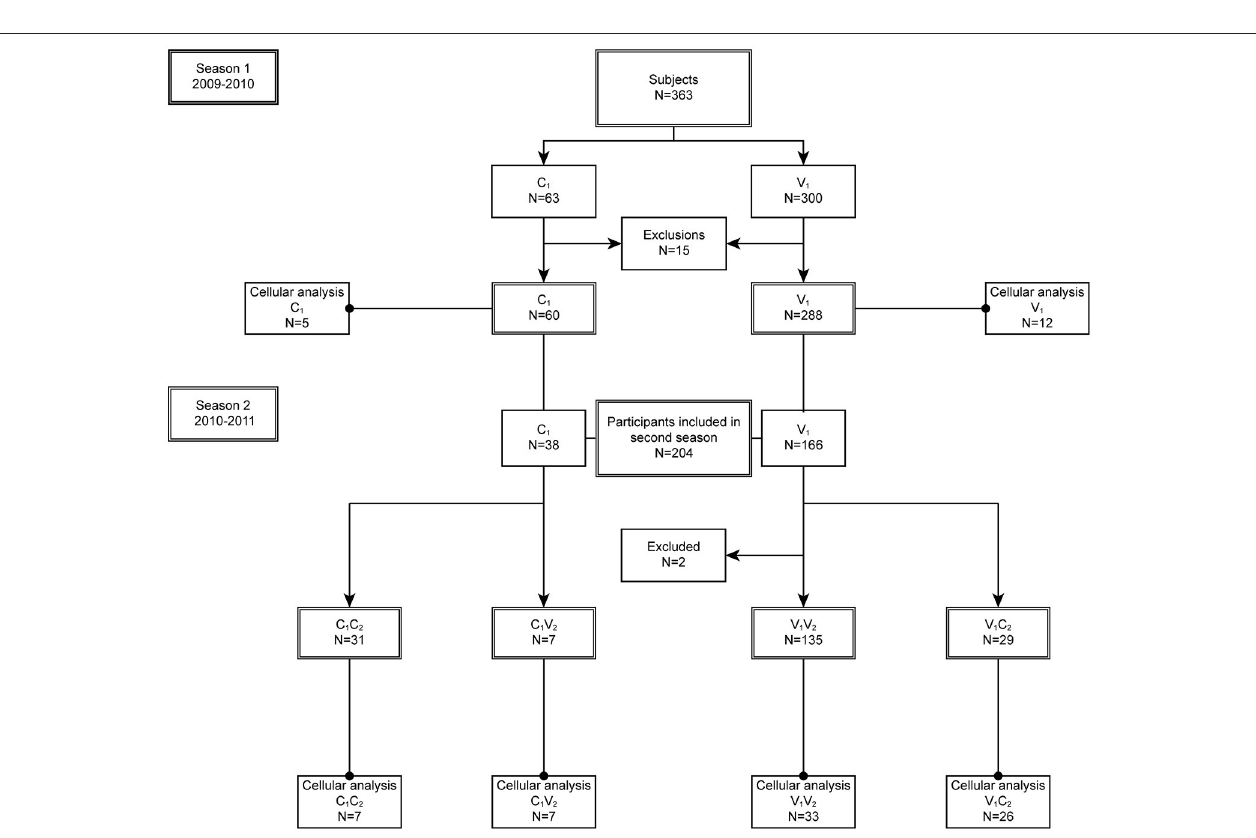
FIGURE 2 | Study disposition. In season 1 (2009–2010), 15 participants were excluded from the per protocol analysis: eight were lost to follow up, two due to occupational vaccination while in the control group, four only received the first dose of the vaccination, and one individual was too old. In season 2 (2010–2011),